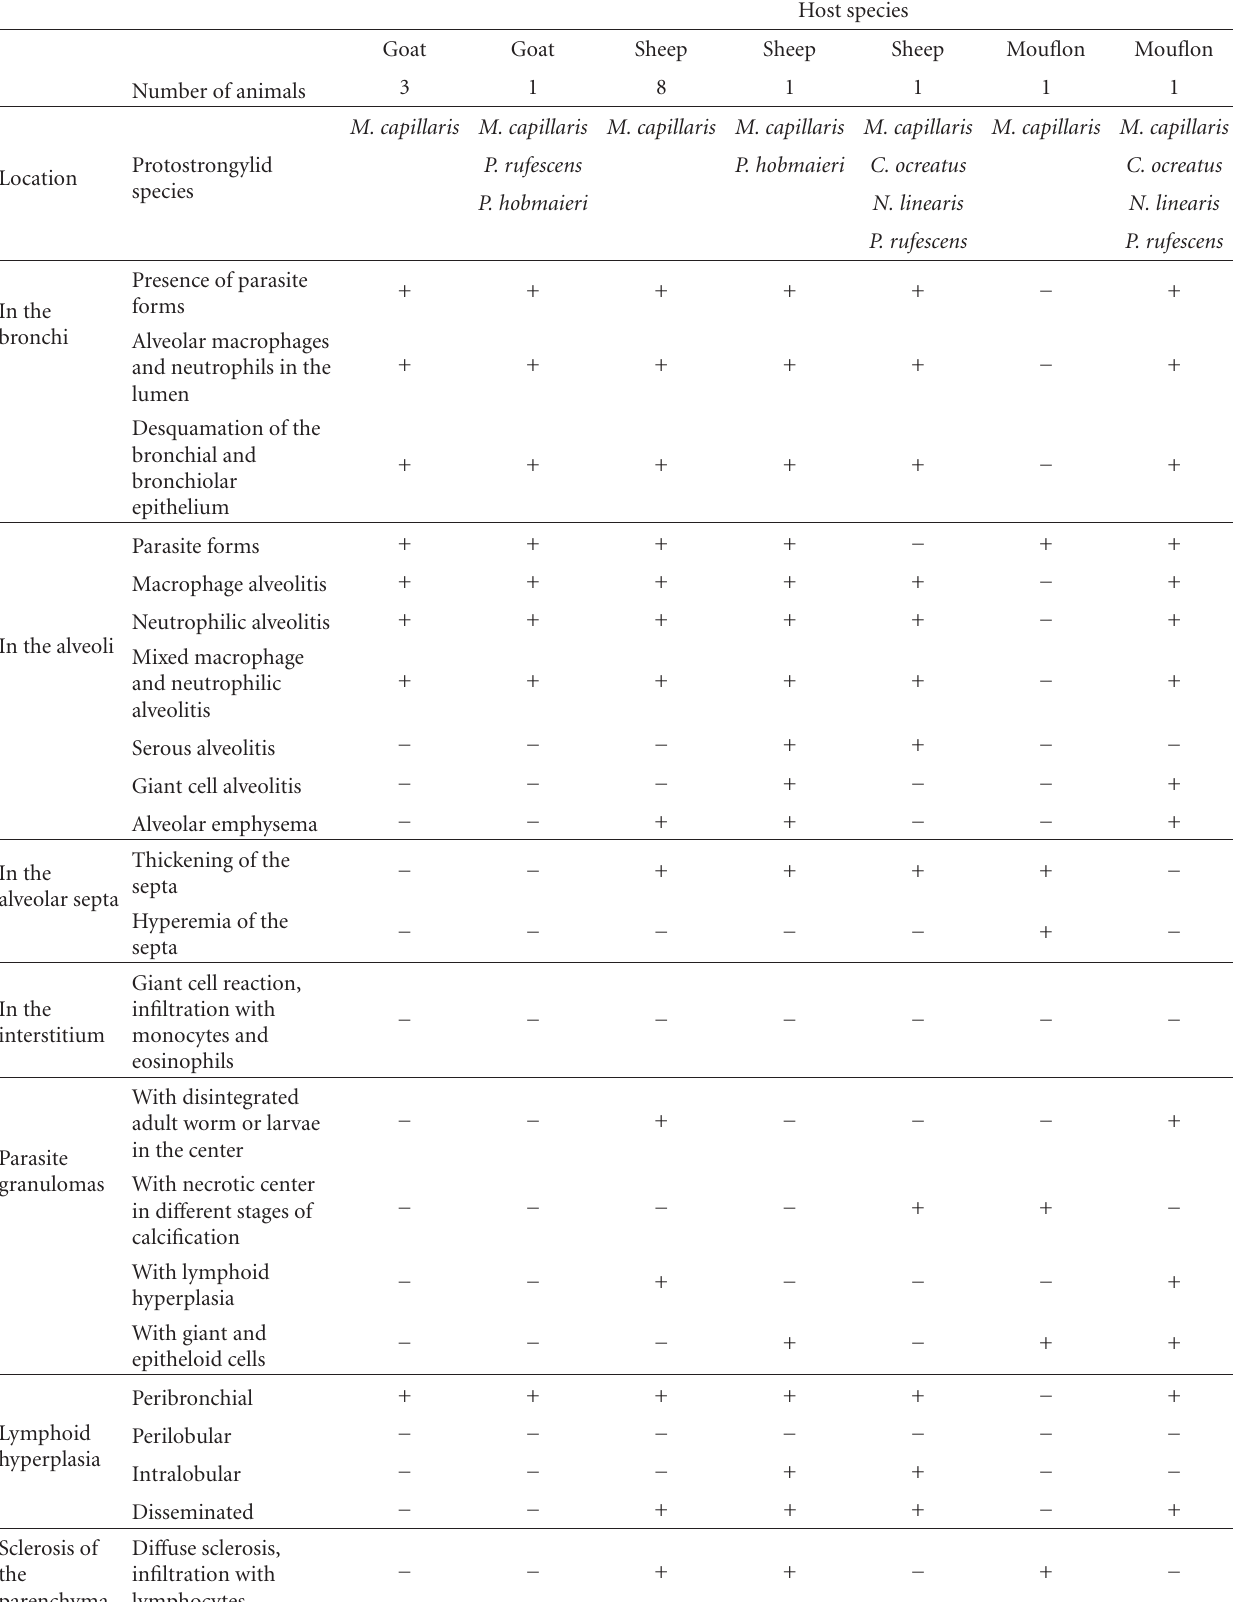
Table 4: Microscopic abnormalities in the lungs of domestic and wild ruminants with natural protostrongylid infections.